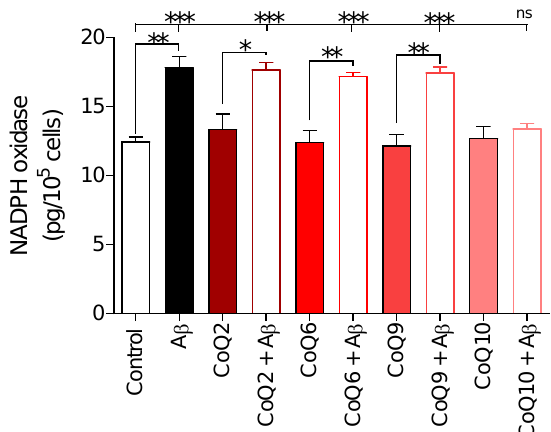
Figure 2. Characterization of NADPH oxidase levels. bEnd.3 cells were pretreated with CoQ2, CoQ6, CoQ9, or CoQ10 for 24 h and then treated with A β 25–35 for 24 h. NADPH oxidase was assessed using a NOX1 ELISA kit. Results are expressed as pg/10 5 cells compared with the standard. Data are presented as the mean ± SEM. Student’s t -test was used to compare the differences between groups treated with the same ubiquinone and Dunnett’s multiple comparison test to compare each A β 25–35 (plus or minus ubiquinone) treatment with the control. ns: not significant, * p < 0.05, ** p < 0.01, *** p < 0.001 ( n = 3).